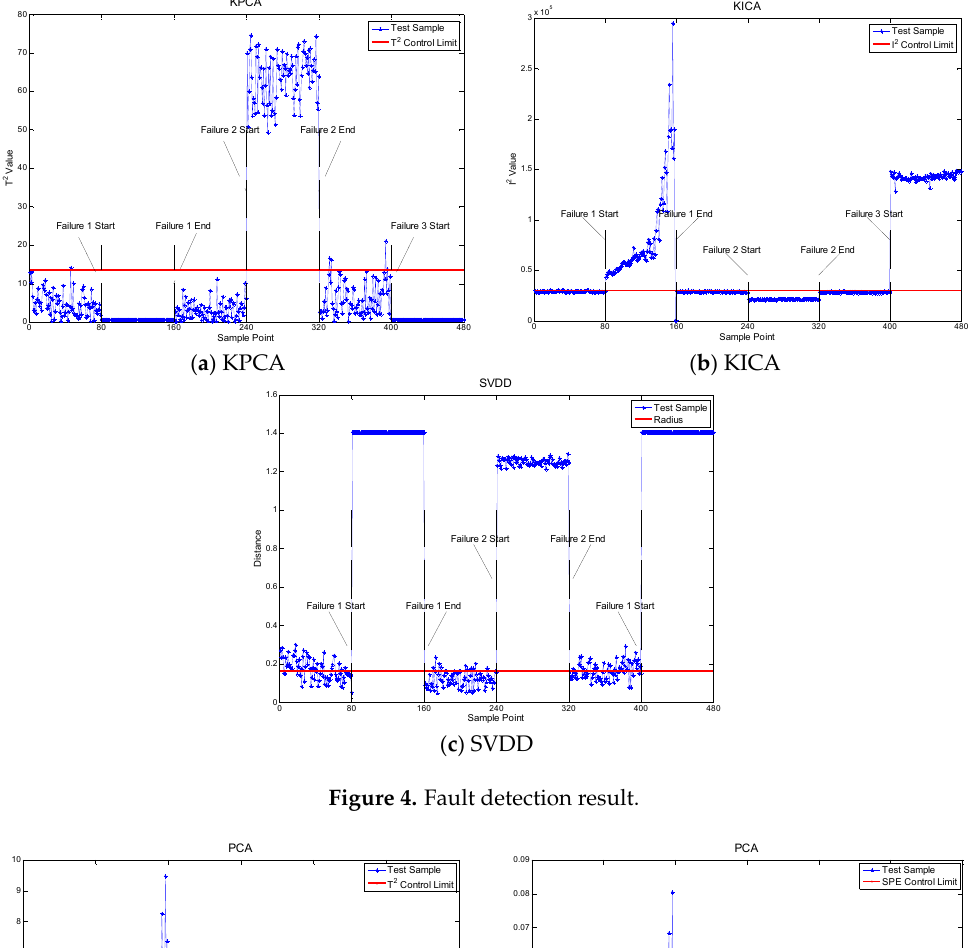
Figure 4. Fault detection result.